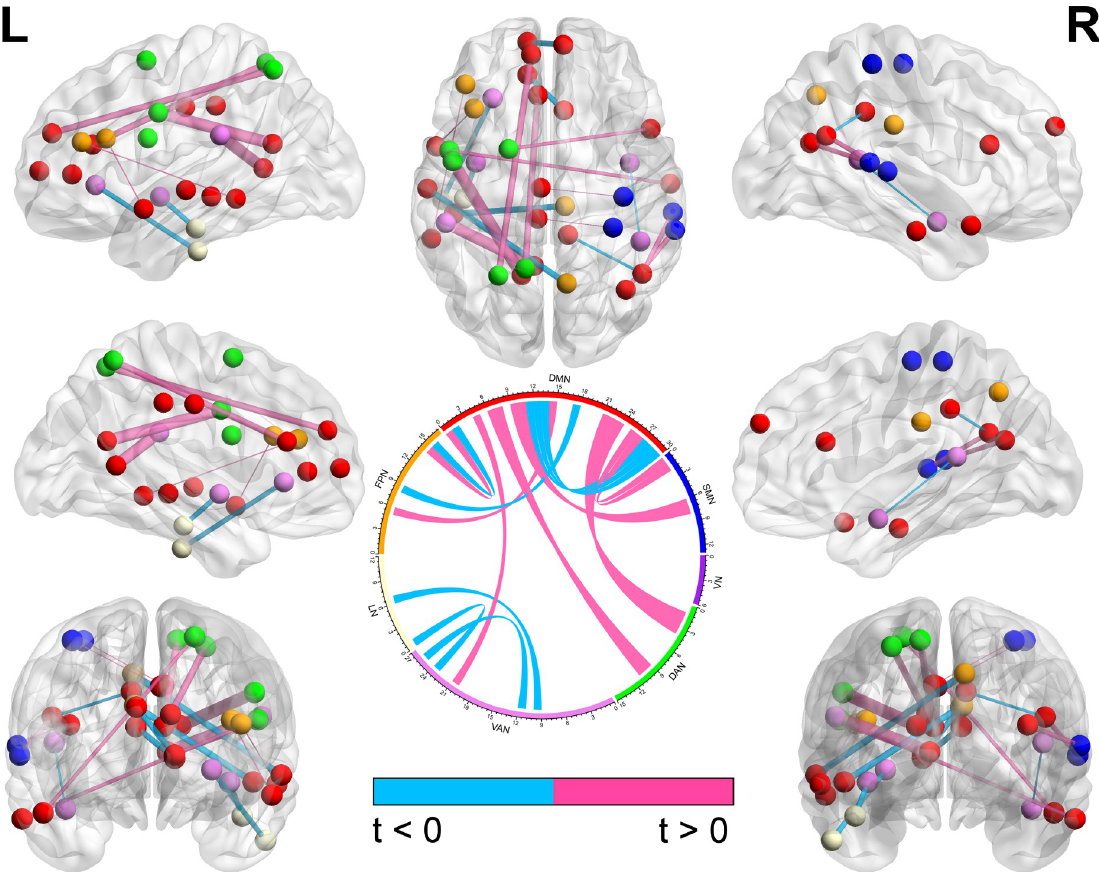
Fig 4. The changed functional connections of brain nodes in the CFS group with P < 0.05 between interventions. The different colors of brain nodes represent different brain networks. The thickness of nodes’ connections represents the statistical value between interventions; the statistical value that was decreased after the intervention is displayed with blue color and that which was increased with pink color.